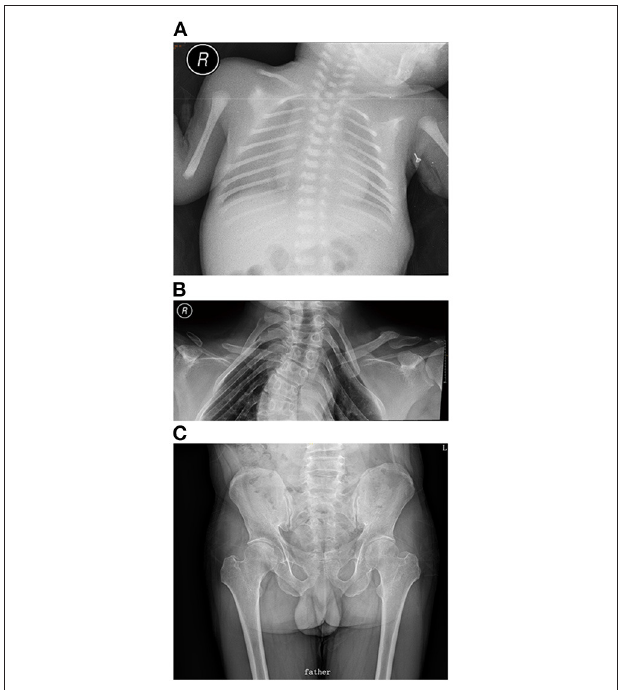
FIGURE 2 | (A) Chest x-ray of the propositus: cone-shaped chest, clavicular hypoplasia, enlarged shoulder joint space. (B) Chest x-ray of father: cone-shaped chest, fragmented clavicles, scoliosis. (C) Pelvic x-ray of father: narrow pelvis, with short femoral necks, and short pubic rami.